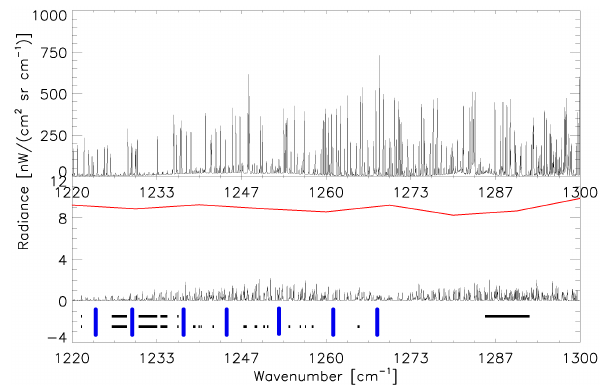
Fig. 1. Top: Simulated spectrum for tropical conditions and all gases included. Bottom: Contribution of Hydrogen Peroxide (note the different scale). Calculations are done for a tangent altitude of 35 km. The red line in the bottom figure shows the typical spectral noise in the MIPAS measurements. Black horizontal bars represent the microwindows used for data analysis; bottom: below 44.5 km tangent altitude, top: above 44.5 km tangent altitude. All sub-microwindows in between a pair of vertical blue bars belong to one main microwindow.